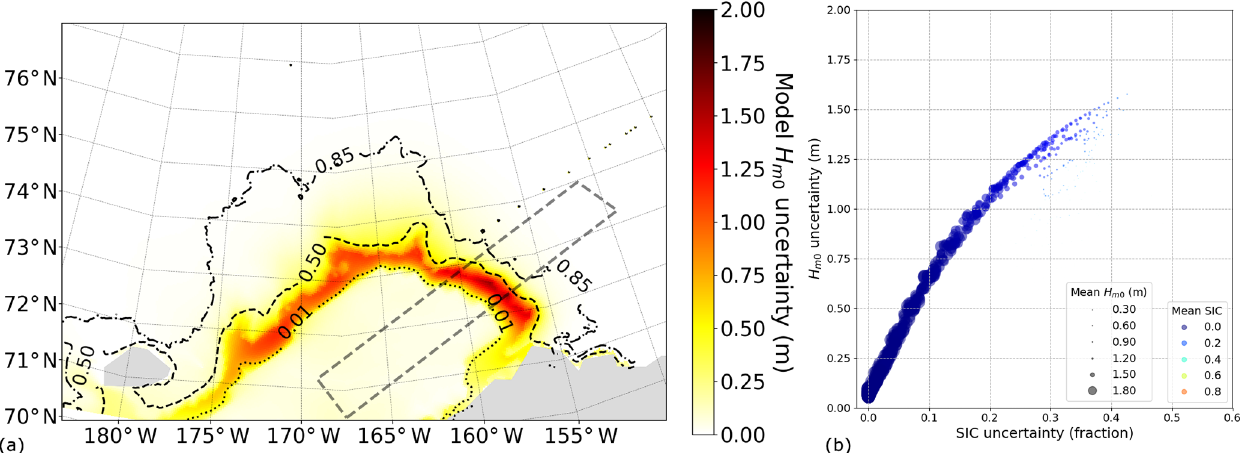
Figure 7. TodaiWW3-ArCS simulation on 15 November 2018, 00:00, during southwesterly on-ice wind conditions as shown in Fig. 6a. (a) (cid:49)H m map with 0.01 (dotted), 0.50 (dashed), and 0.85 (dash-dotted) mean( c i ) contours shown in black. (b) Bivariate model (cid:49)H m 0 and (cid:49)c i uncertainty data in an enhanced scatter plot for the quadrilateral area. The marker sizes are scaled by mean (H m colours indicate mean( c i